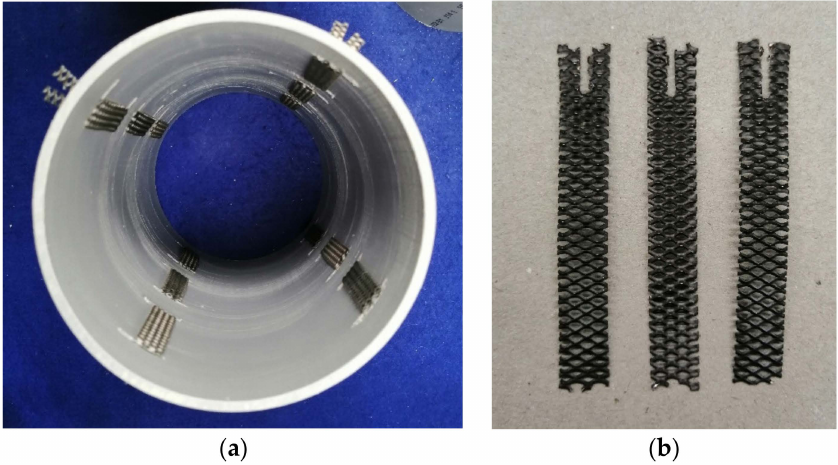
Figure 2. PVC formwork with 12 MMO grid electrodes at three height levels with angular distances of 90 ◦ ( a ) and MMO grid electrodes with notches for the clamp ( b